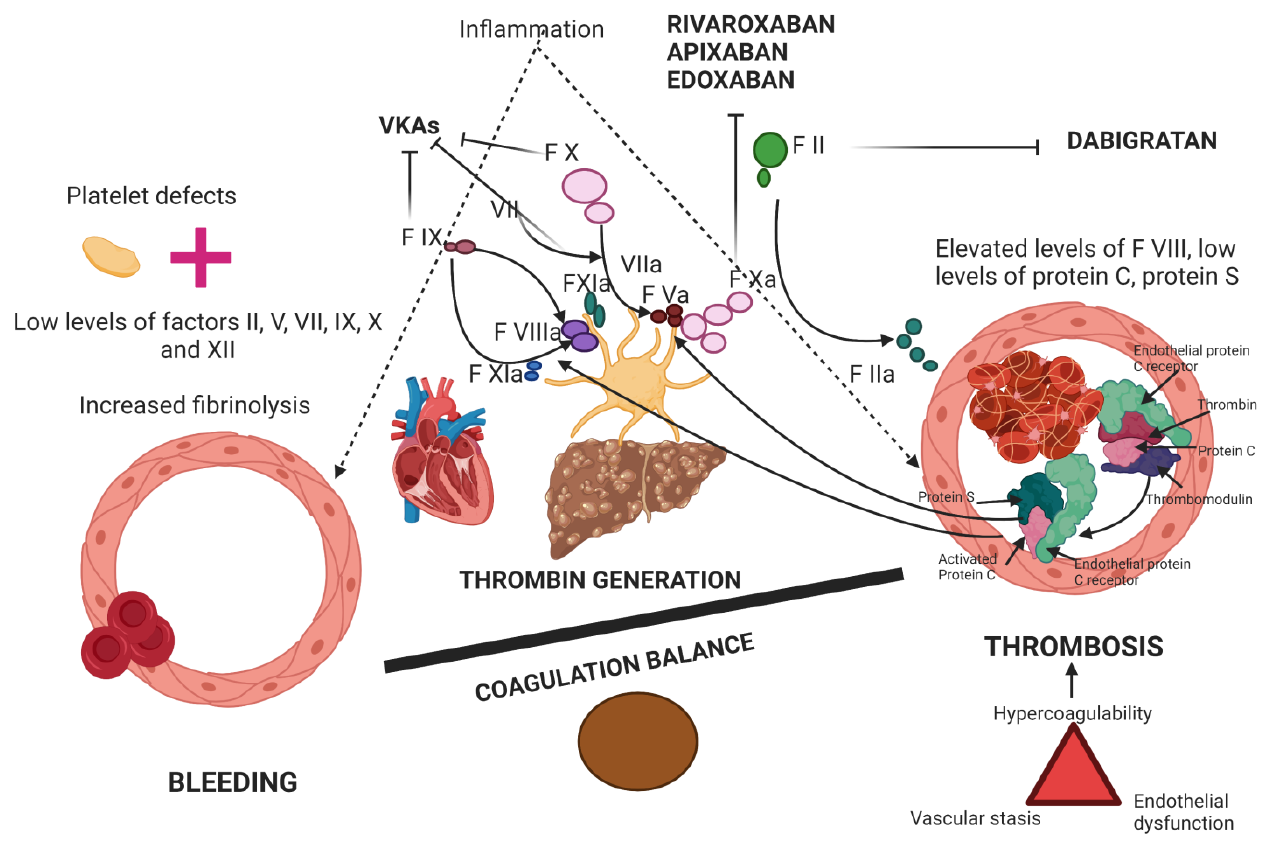
Figure 2. Coagulation balance in patients with liver cirrhosis.